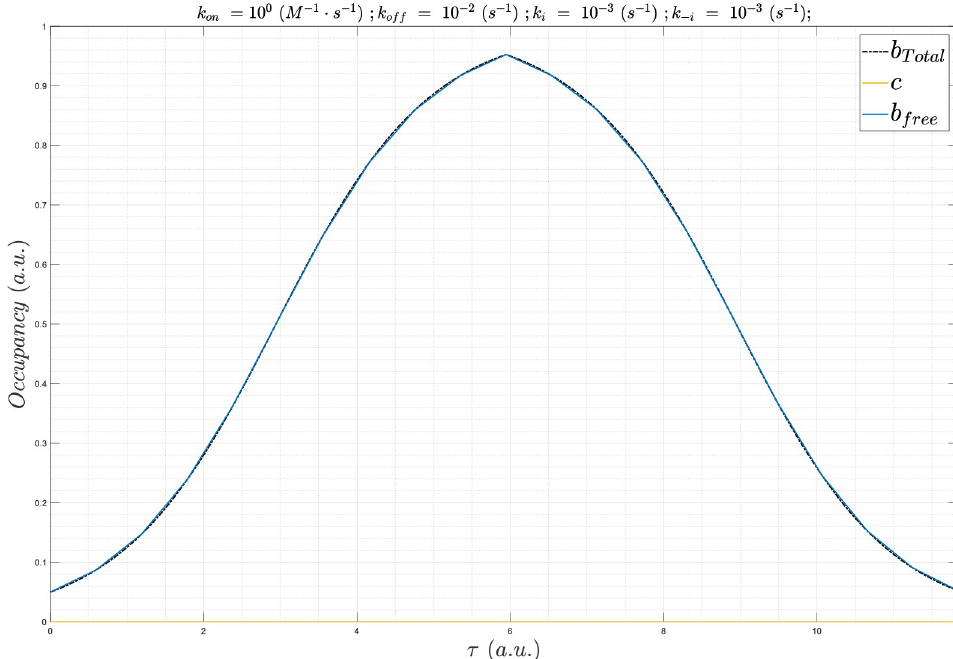
Fig 7. The buildup and decay phases of B total ( τ ) simulated using Eqs 6C and 6E (scenario 2). The maximum B total ( τ ) is normalized to 1.0, and always occurs at τ = 6. The morphology approximately resembles that of the state transition curves in Figs 1B and 2A, keeping in mind that the plot is normalized in all cases to a uniform width of τ = 12 at all Λ .